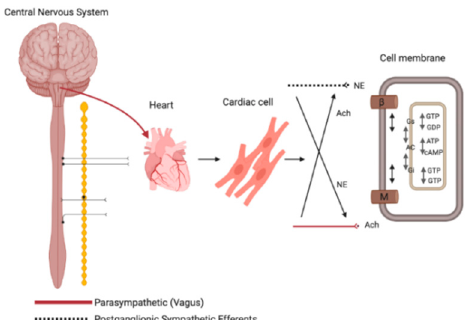
Figure 1. Sympathetic and parasympathetic mechanism in the autonomic nervous system (ANS). Parasympathetic vagal activity (in red) inhibits noradrenaline (NE) which in turn inhibit acetylcholine release (ACh). Released ACh binds to M muscarinic receptors (M) and, through the inhibition of Protein G1, coupled to adenylate cyclase (AC). Released NE from postganglionic sympathetic nerve endings (dotted line) binds to β -adrenergic receptors ( β ) which activate AC increasing intracellular cyclic-AMP (cAMP).